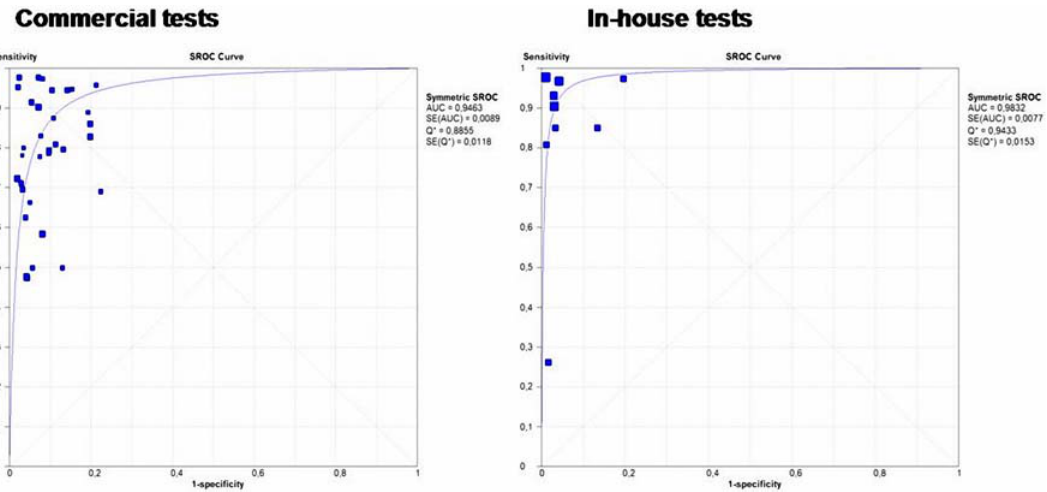
Figure 6. Summary Receiver Operator Curves (SROC) for commercial and in-house tests from Serum IgG-ELISA. Each solid square represents an individual study in the meta-analysis. The curve is the regression line that summarizes the overall diagnostic accuracy. AUC=area under curve, SE (AUC)=standard error of AUC, Q*=index defined by point of the SROC curve where the sensitivity and specificity are equal; SE (Q*)=standard error of Q* index.